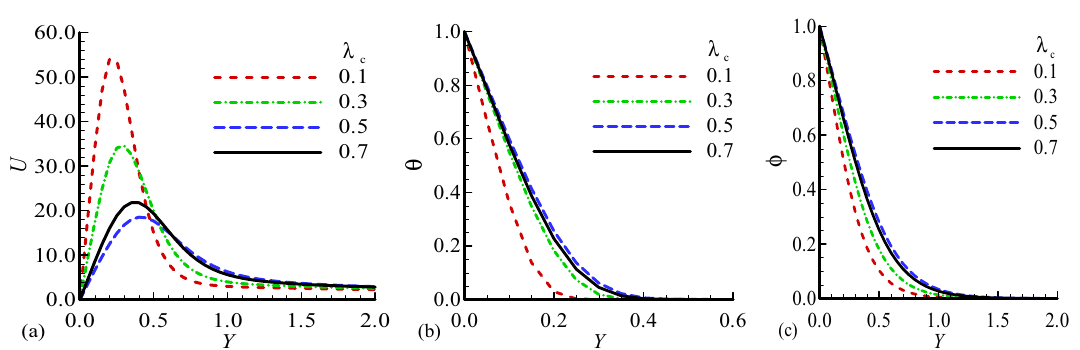
Figure 2. Dimensionless ( a ) Velocity U, ( b ) Temperature θ and ( c ) mass distribution φ for different values of (cid:31) T = 1.0, 10.0, 20.0, 50.0 while n = 0.3, E = 0.2 , γ = 0.1 , (cid:31) = 0.5 , β = 0.5 , (cid:31) c = 20 , Pr = 7.0, Sc = 0.6.